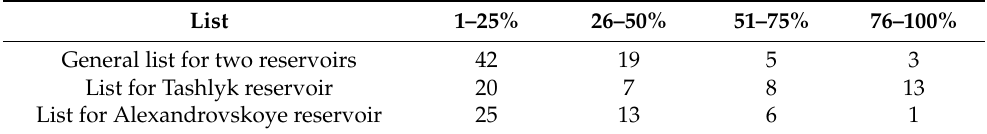
Table 2. Number of LIT distributions in phytoplankton of the surface horizon of the Tashlyk and Alexandrovskoye reservoirs with a given frequency of occurrence in percentage